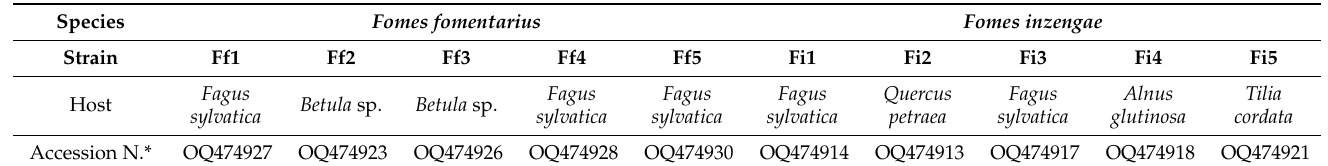
Table 1. Fungal strains used for fungal exposure of mass-loss samples and original tree host species from which basidiomes were collected. Bold strains were used for the fungal exposure of samples for mechanical testing.